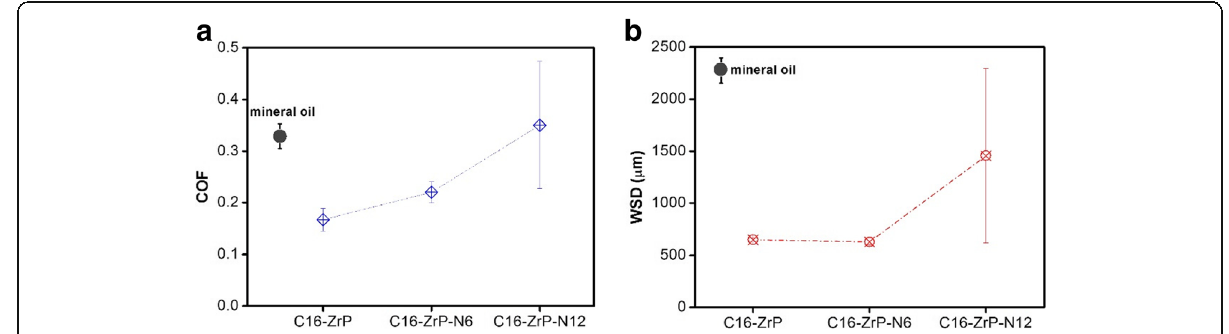
Fig. 6 a Friction coefficients and b wear scar diameters of surface-modified ZrP nanoplatelets without and with